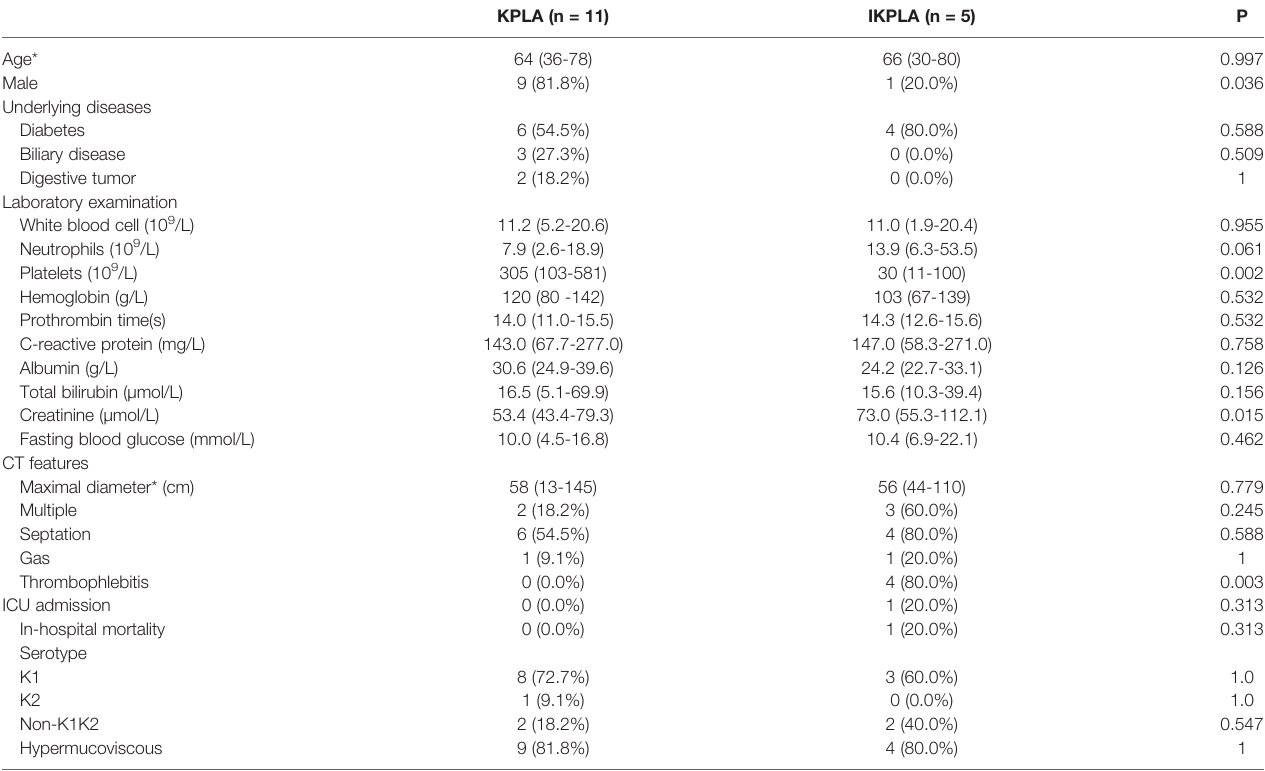
TABLE 1 | Comparison of clinical, computed tomography, and microbial characteristics between KPLA and IKPLA.